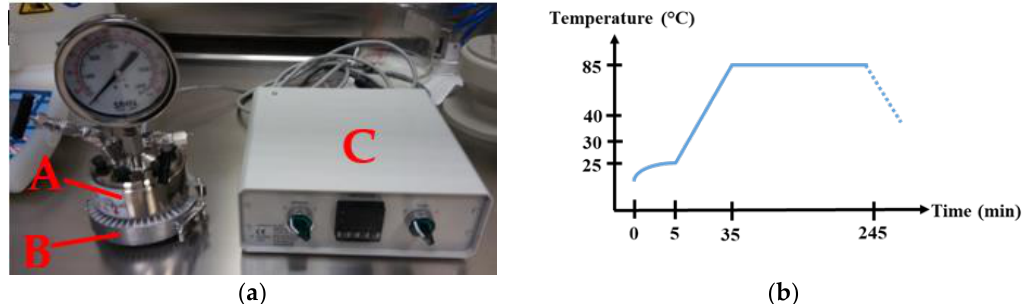
Figure 1. ( a ) Hydrothermal growth set up with A: Stainless steel autoclave, B: Ring heating system, C: Temperature regulator. ( b ) Temperature profile set.